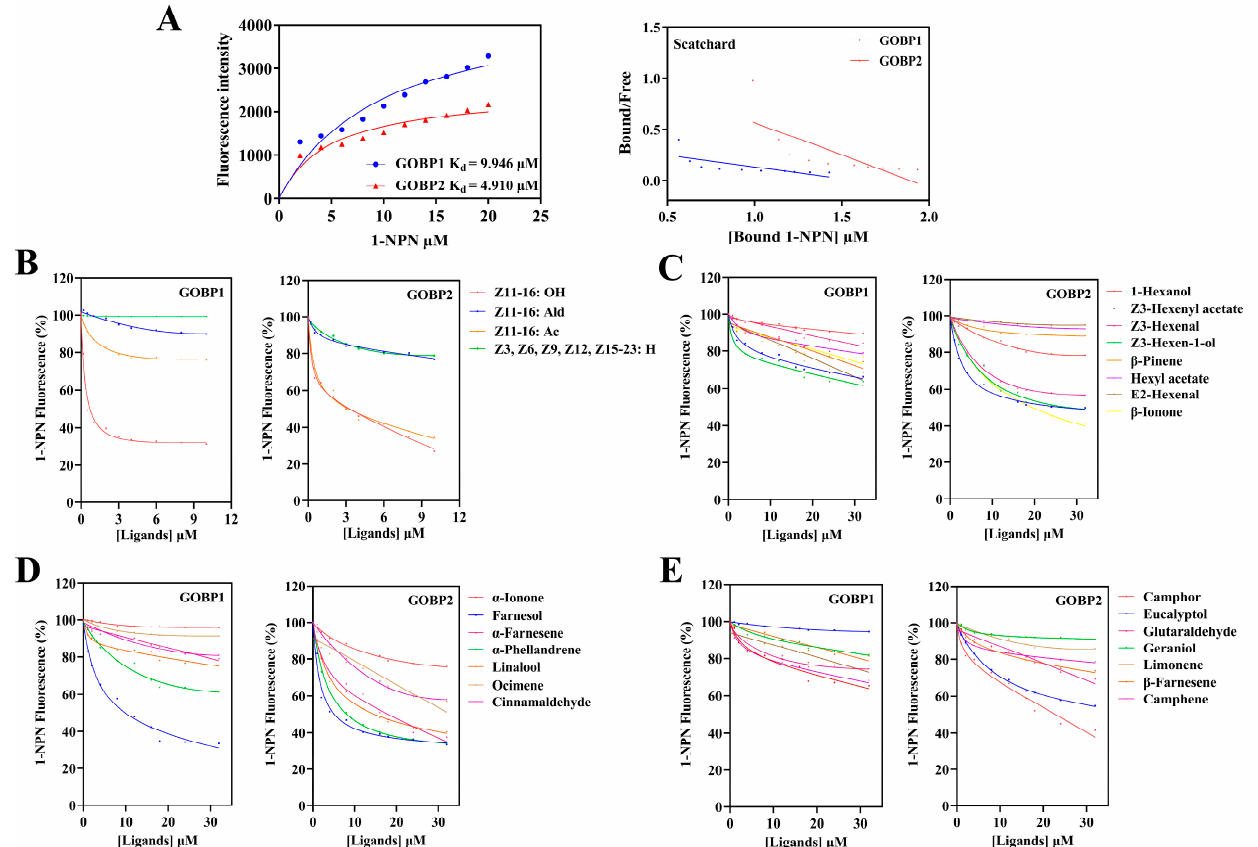
Figure 4. Binding of selected ligands to OachGOBPs. ( A ): Binding curves of 1-NPN to OachGOBP1 and OachGOBP2 with relative Scatchard plots. ( B ): Binding curves of OachGOBPs to 4 sex pheromone components. ( C – E ): Binding curves of OachGOBPs to 22 volatiles of camphor. The ligand names are shown on the right of the curves. The binding data of components were calculated and listed in Table 1.